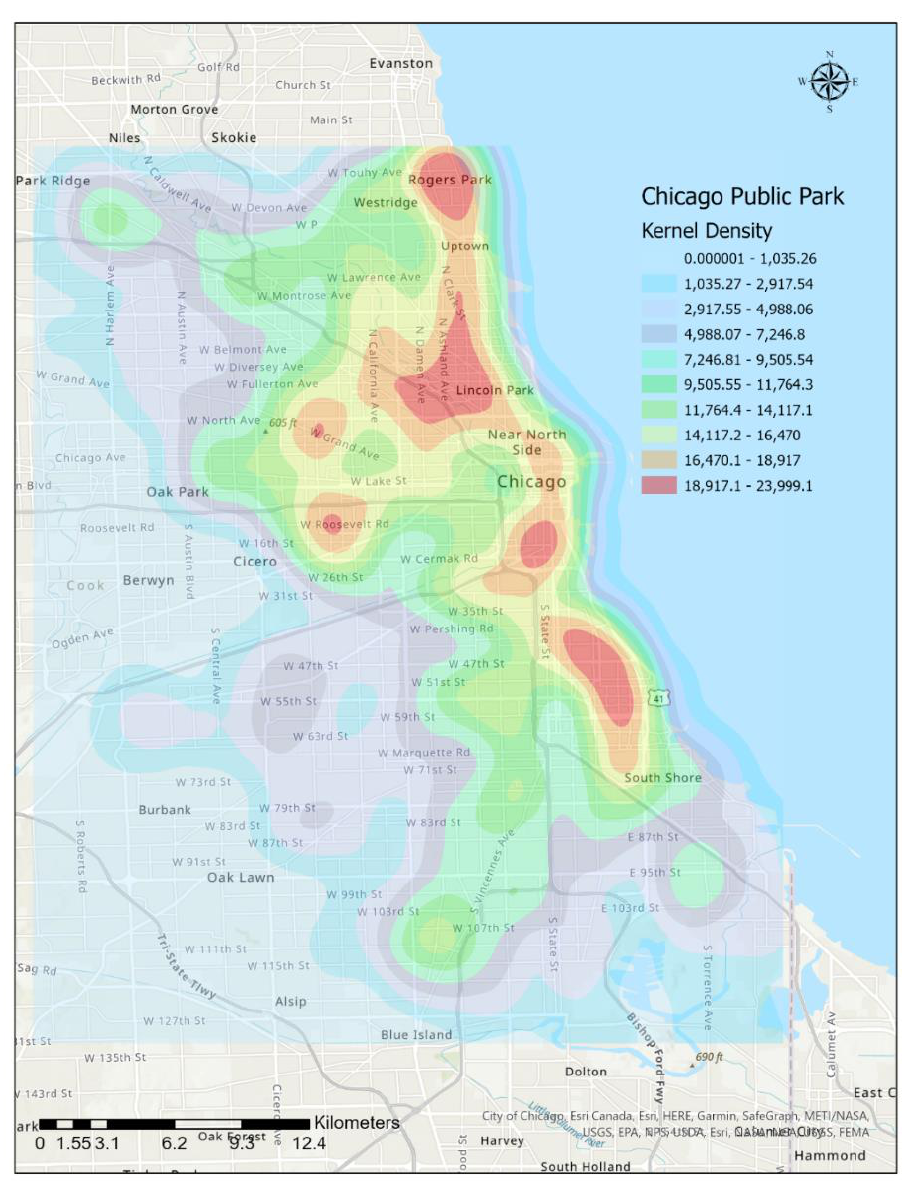
Figure 4. Kernel density map of public parks in Chicago.